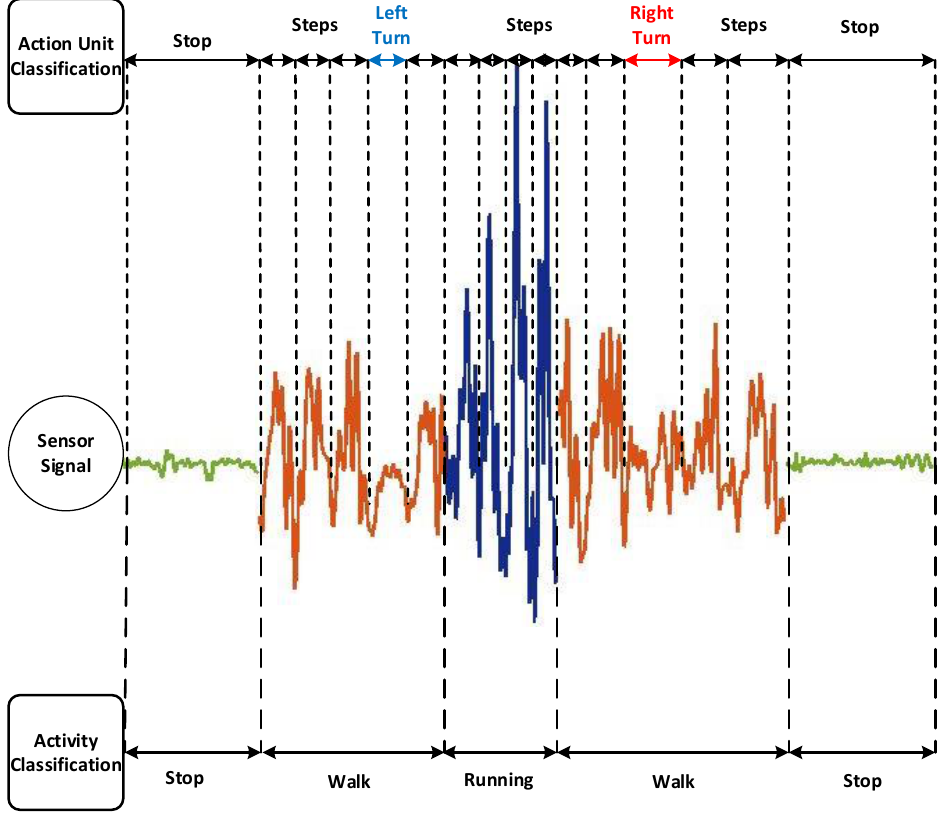
Figure 6. Different activity states and distinct action units